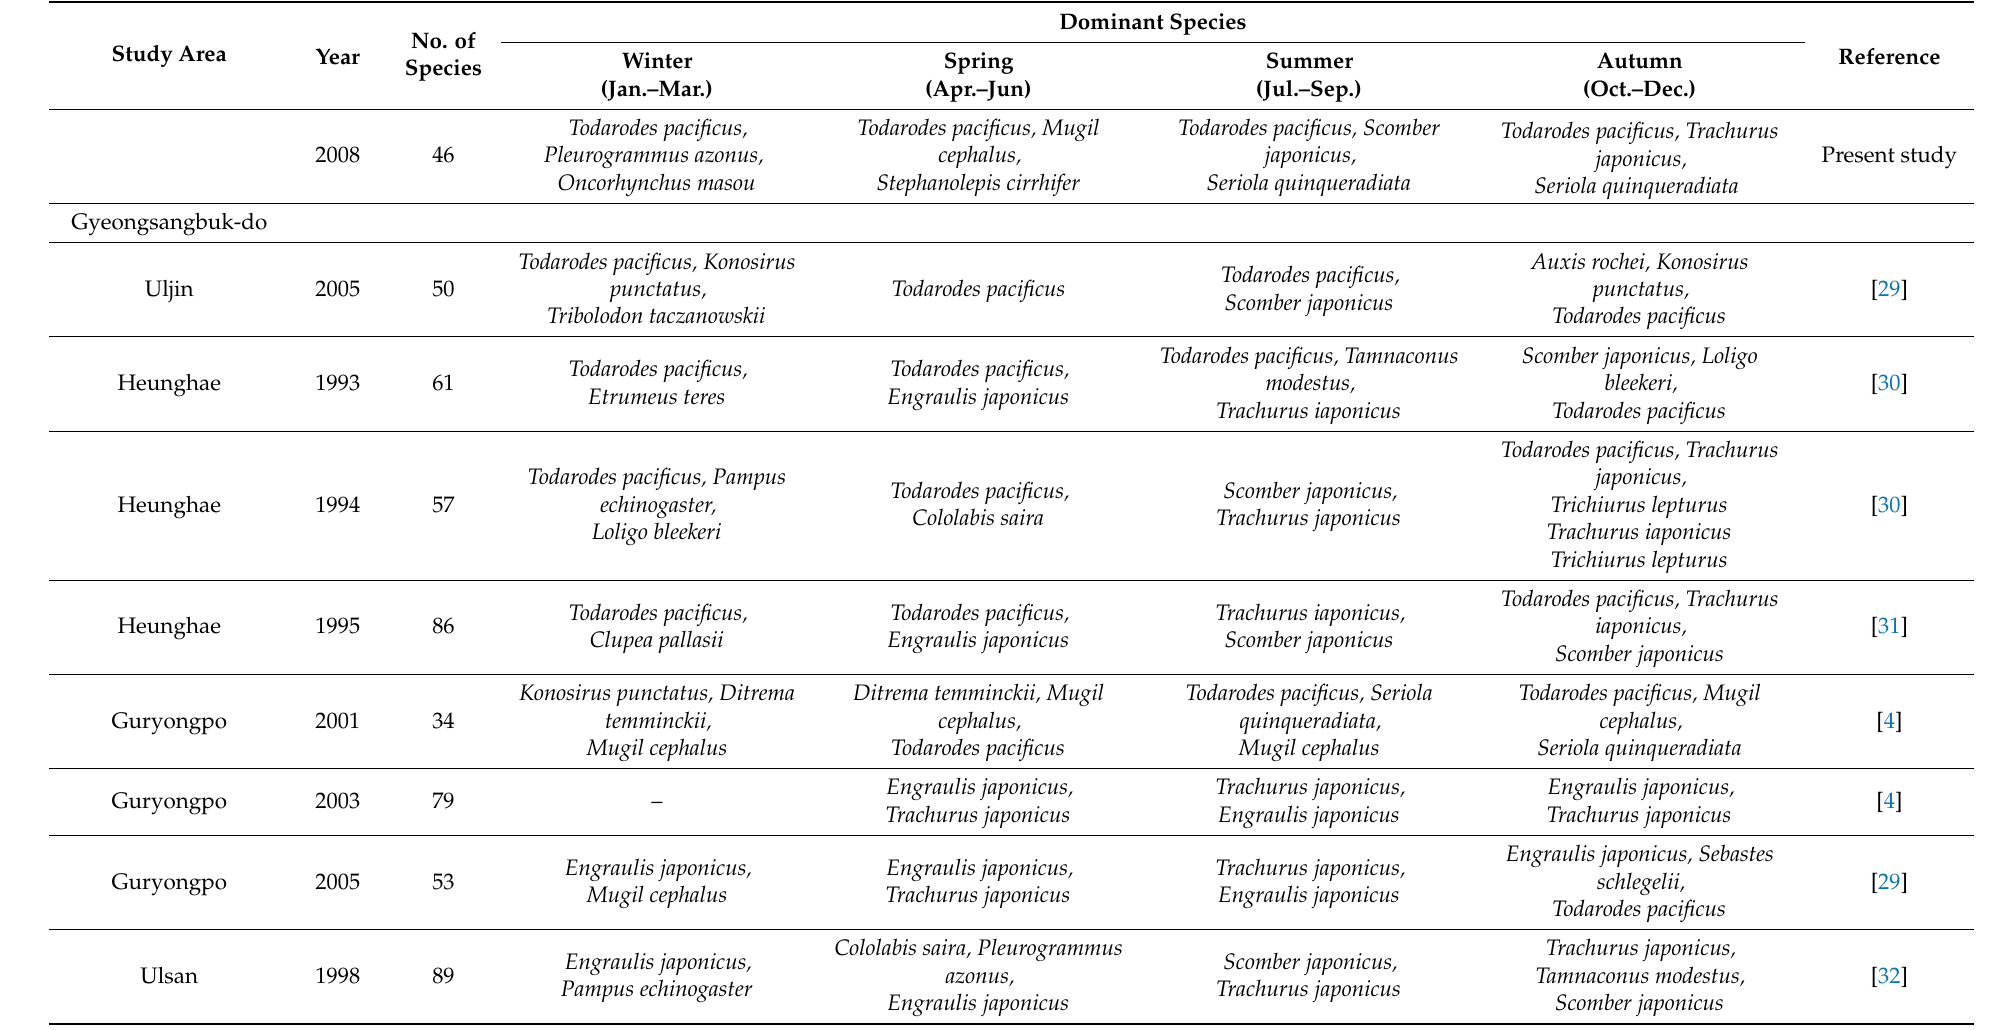
Table 3. Seasonal variations of the dominant species of fishes captured in set nets from the East Sea of